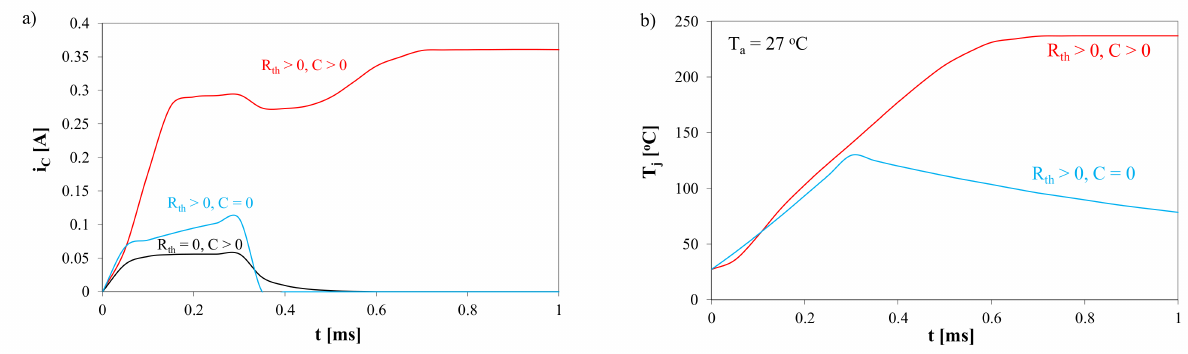
Figure 10. Collector current ( a ) and junction temperature ( b ) with and without electrical inertia taken into